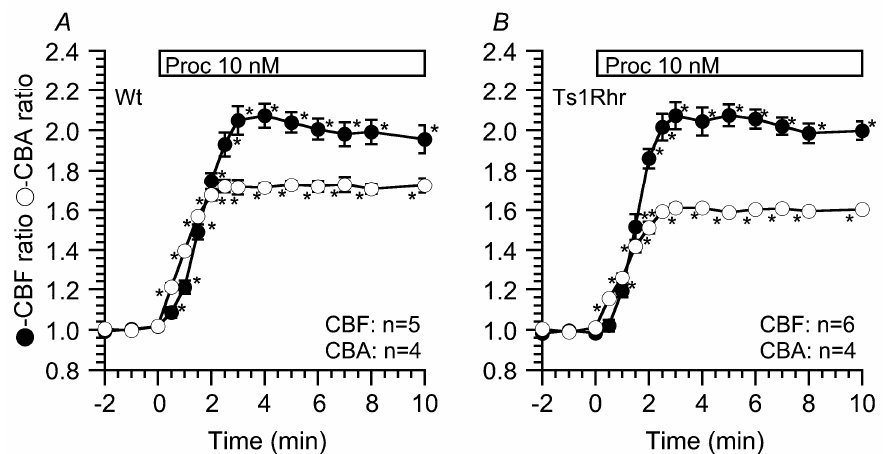
Figure 3. Stimulation with procaterol (10 nM) similarly increased the CBA and CBF ratios in airway cilia of Wt ( A ) and Ts1Rhr ( B ). The time course of the procaterol-stimulated CBF increase is slower than that of the CBA increase, and the plateau levels of the CBF and CBA increases by procaterol stimulation in Ts1Rhr are also similar to those in Wt. * significantly different vs values before stimulation ( p < 0.05)